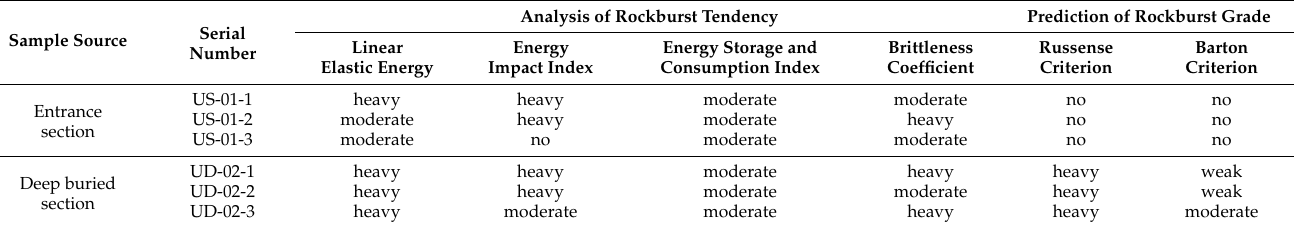
Table 6. Results of the judging of rockburst